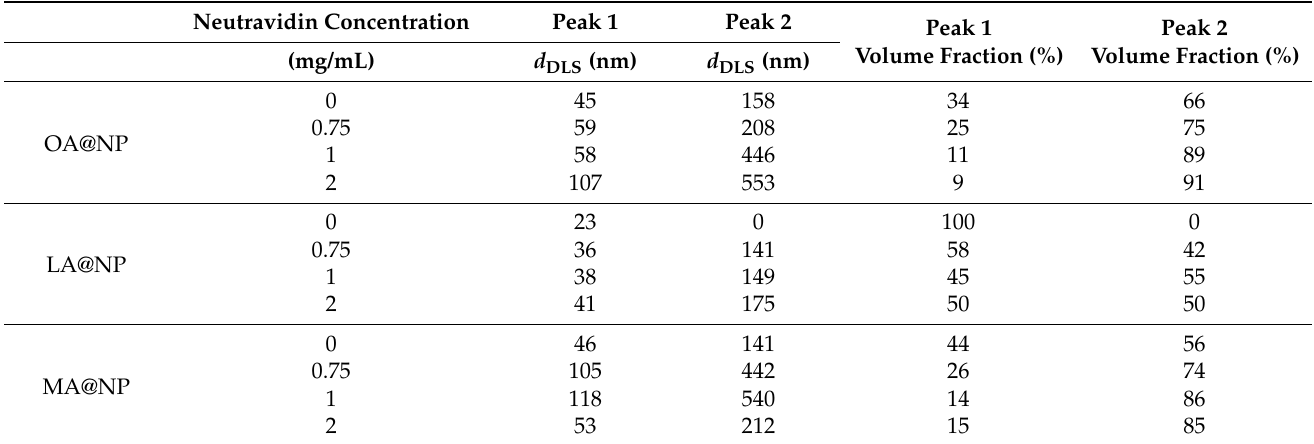
Table 4. Neutravidin concentrations for the particle bioconjugation and the corresponding main parameters of the two-peaked volume distribution of